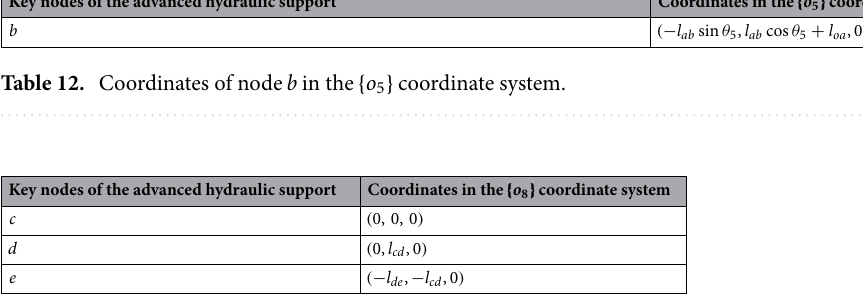
Table 13. Coordinates of nodes c , d , and e in the { o 8 } coordinate system.